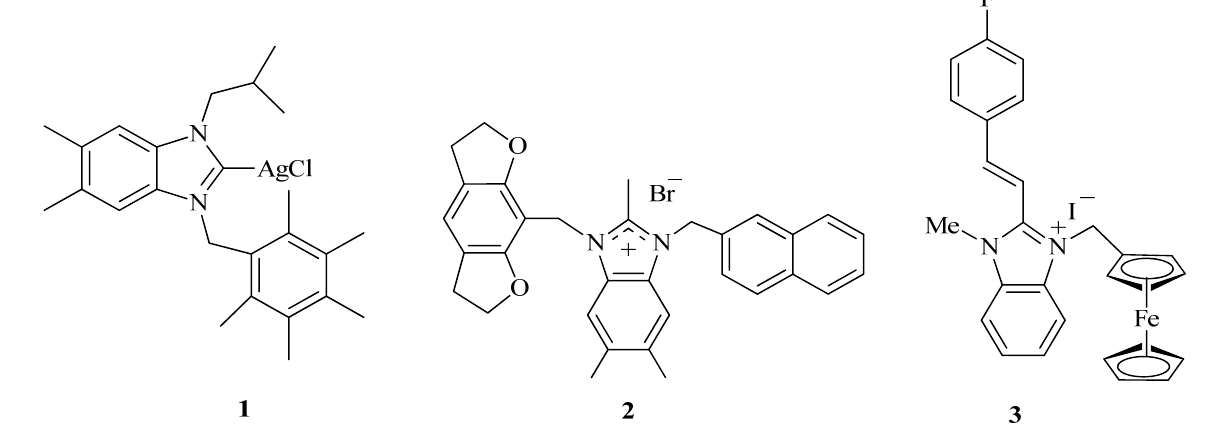
Figure 1. The chemical structures of biologically active benzimidazolium salts.